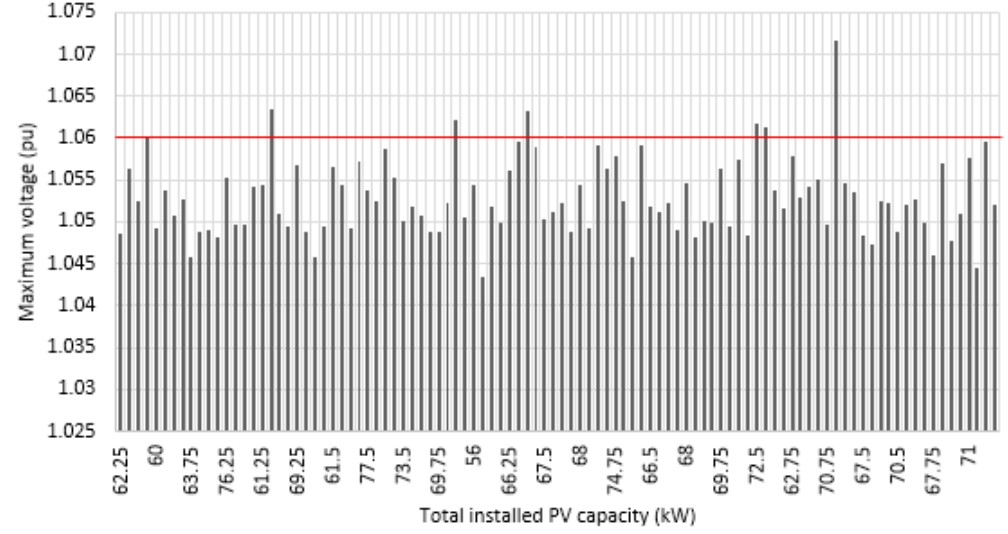
Figure 9: Variation of maximum voltage with the total installed PV capacity (15 PV units).